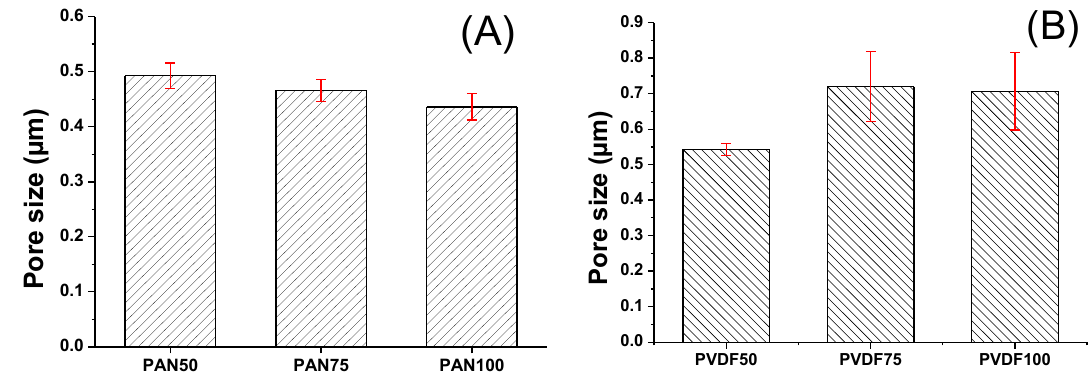
Figure 9. The relationship between the mean pore size and the laminating pressure of ( A ) PAN and ( B ) PVDF multilayer nanofibrous membranes.